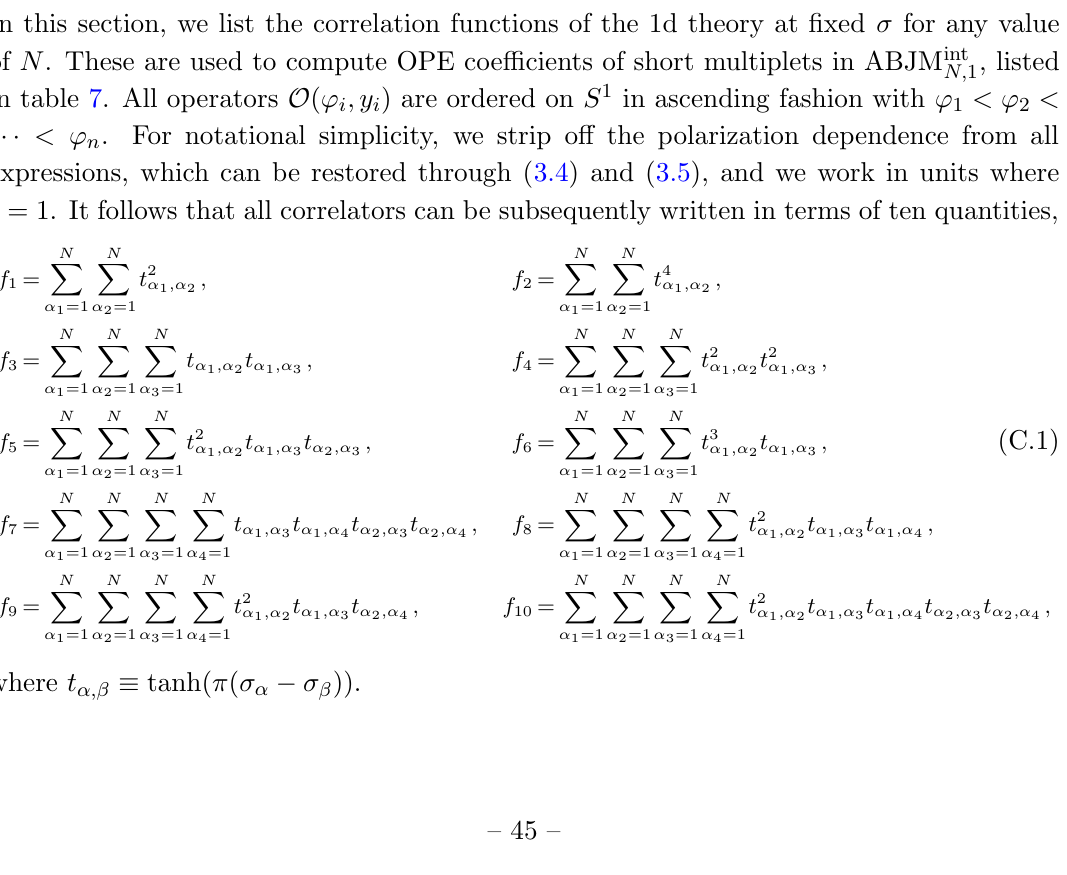
Table 31 . All possible conformal primaries in O 294 superconformal